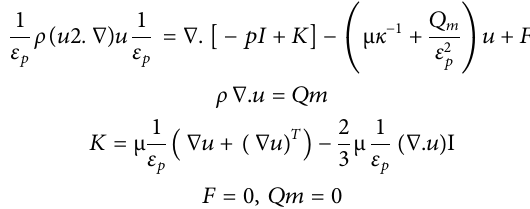
Frontiers in Bioengineering and Biotechnology |